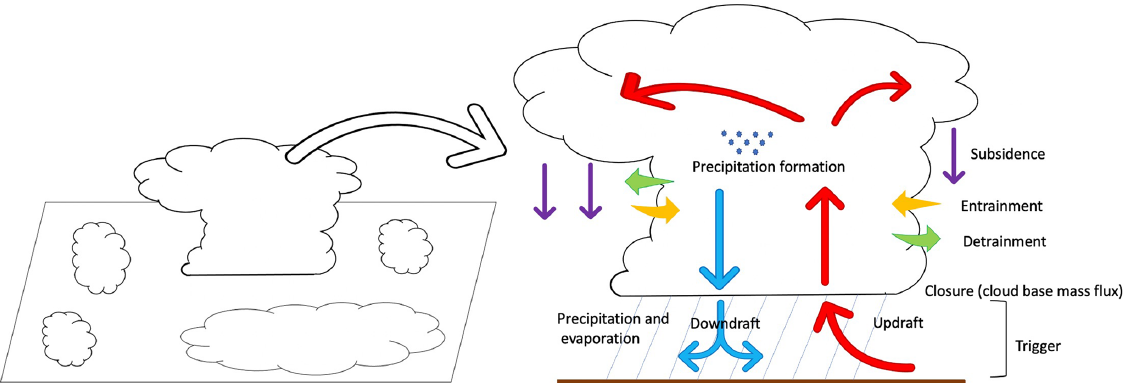
Figure 4. Simulated 24h position and pressure for Typhoon Megi (up) and Typhoon Chaba (down) using 15 ensembles in the ECMWF IFS model at 18km horizontal grid size. Each marker represents one ensemble member. Square markers indicate observations. The simulations start on 26 September 2016 at 06:00UTC for Typhoon Megi and on 3 October 2016 at 00:00UTC for Typhoon Chaba. Figures on the left depict observations (obs) and perturbed initial conditions (pert init conds), while figures on the right show seven perturbed convection parameters (pert conv param) using the ECMWF stochastically perturbed parameterization (SPP). The perturbed parameters are organized entrainment, entrainment for shallow convection, turbulent detrainment, adjustment time, rain conversion, momentum transport, and shallow vs. deep cloud